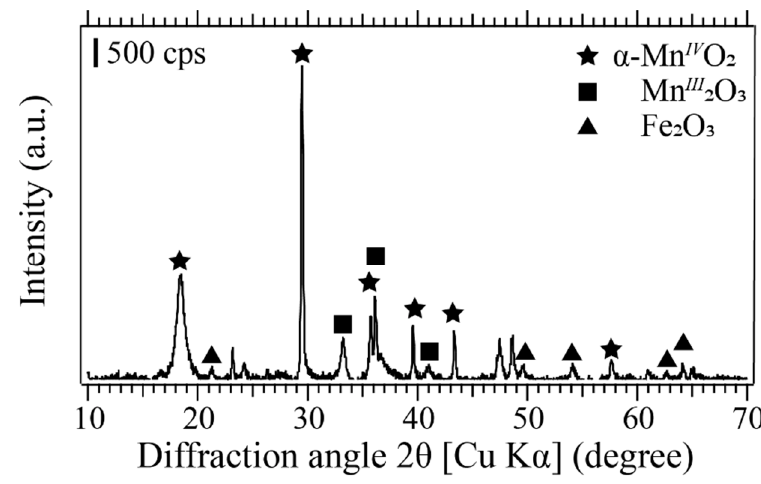
Figure 1. X-ray diffraction patterns of the Mn-deposit collected from the metal refinery wastewater pipe. ★ , α -Mn IV O 2 (JCPDS 44-141); ■ , Mn III 2 O 3 (JCPDS 41-1442); ▲ , Fe 2 O 3 (JCPDS 39-1346).